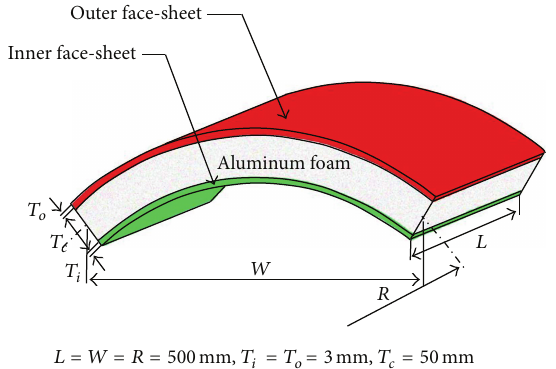
Figure 1: Baseline dimensions of curved sandwich panel.